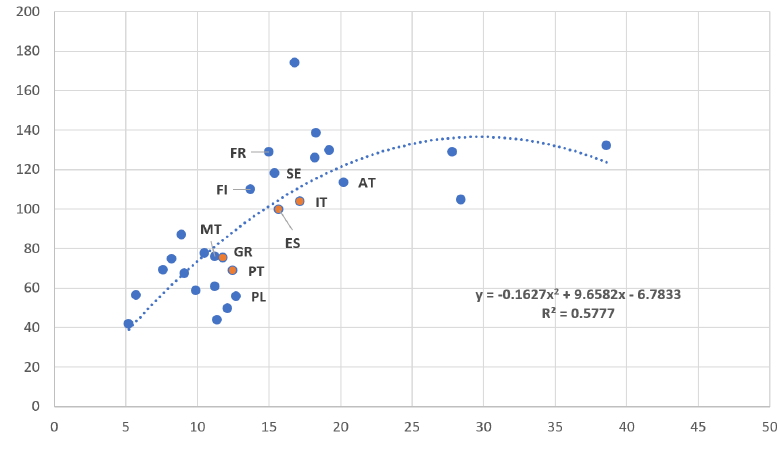
Figure 2: relation between productivity ( y -axis) and percent of underloaded workers ( x -axis) 2010 underloaded workers close to the average: between 11% and 18% for 2010, and between 18% and 27% for 2015, excepting in the case of Italy for this year (something more than 30% of its